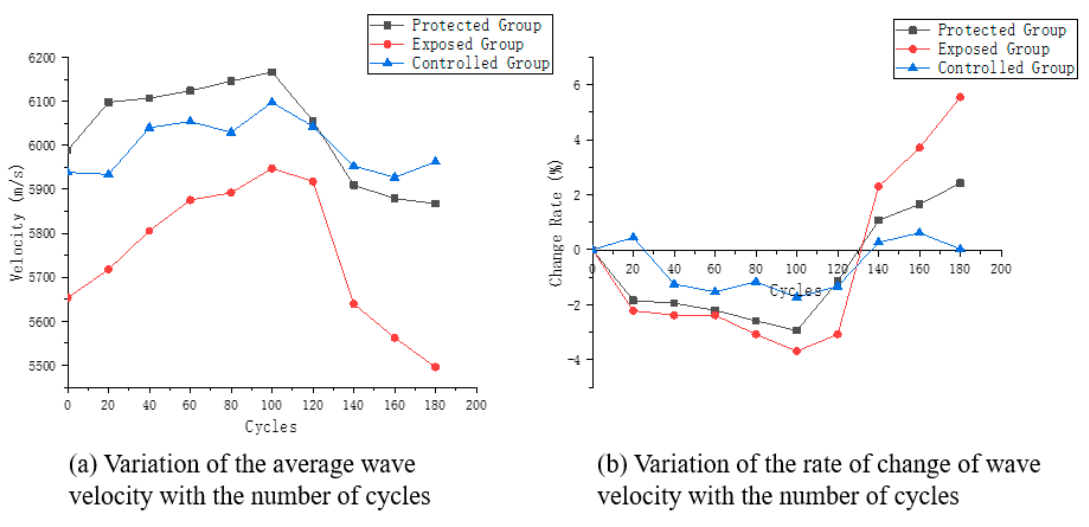
Figure 5. Wave velocity characteristic curve.